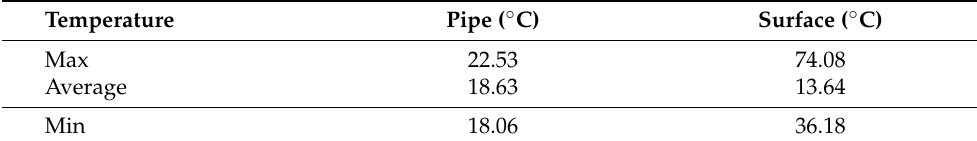
Table 9. Temperature value in the surface of the pavement and in pipeline with Re = 10,000.